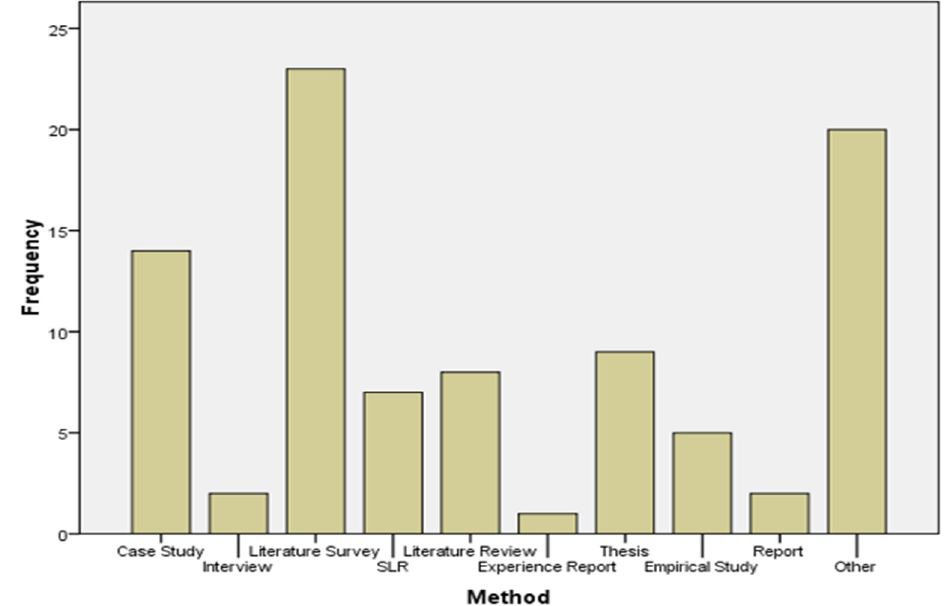
Figure 2. SLR final papers collection from different strategies.